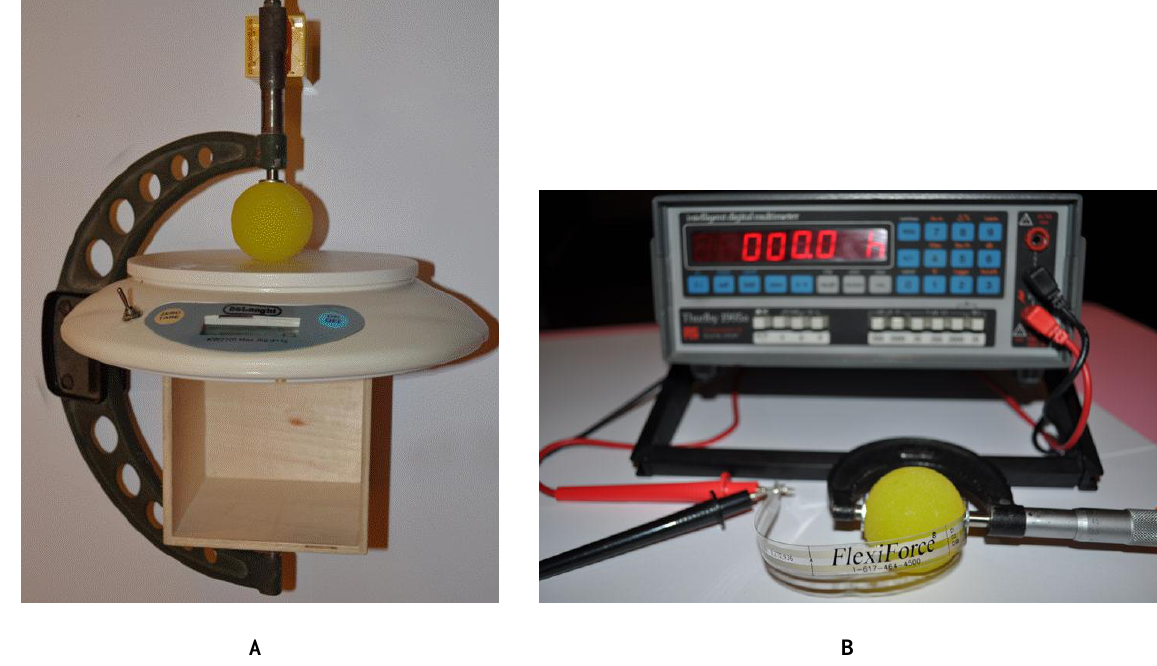
FIGURE 8. Testing of phantoms’ rigidity. (A) Mechanical method, using a large micrometer for 2 mm and an electric weight scale as dymanometer, set horizontally to avoid the weight of the ball. (B) Testing with a single sensor of similar sensitivity with microsensors used on the pincer of ETRT, connected to a multimeter (the electronic system of ETRT not